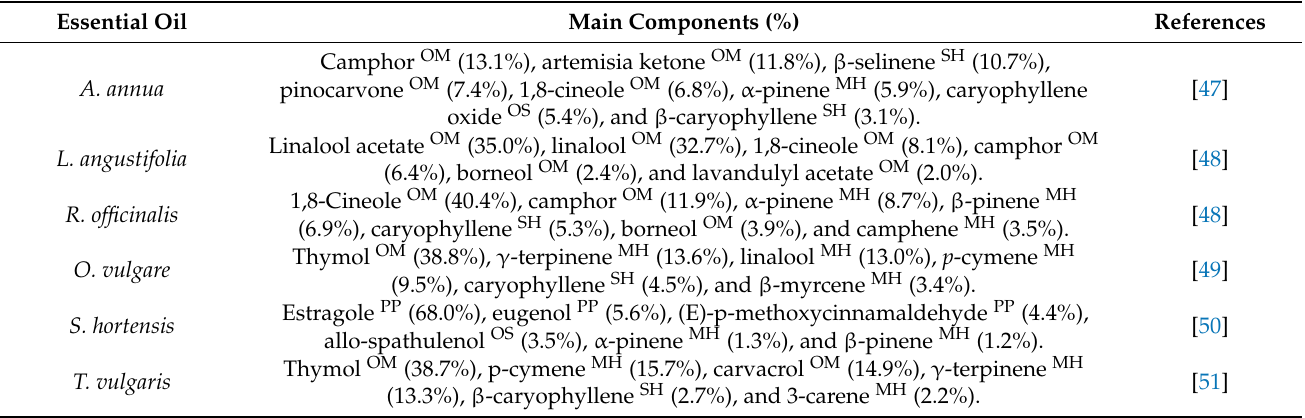
Table 3. Main components of the essential oils of Artemisia annua , Lavandula angustifolia , Origanum vulgare , Rosmarinus officinalis , Satureja hortensis , and Thymus vulgaris